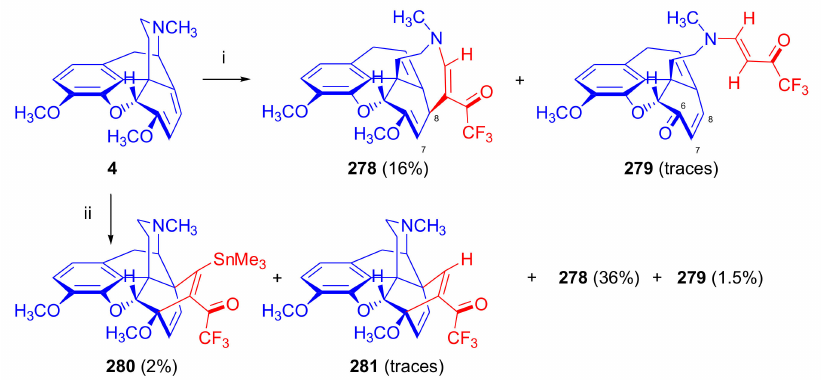
Figure 76. Reaction of thebaine with fluorinated acetylenes. Reagents and conditions : (i): trifluoroacety- lacetylene, THF; (ii):